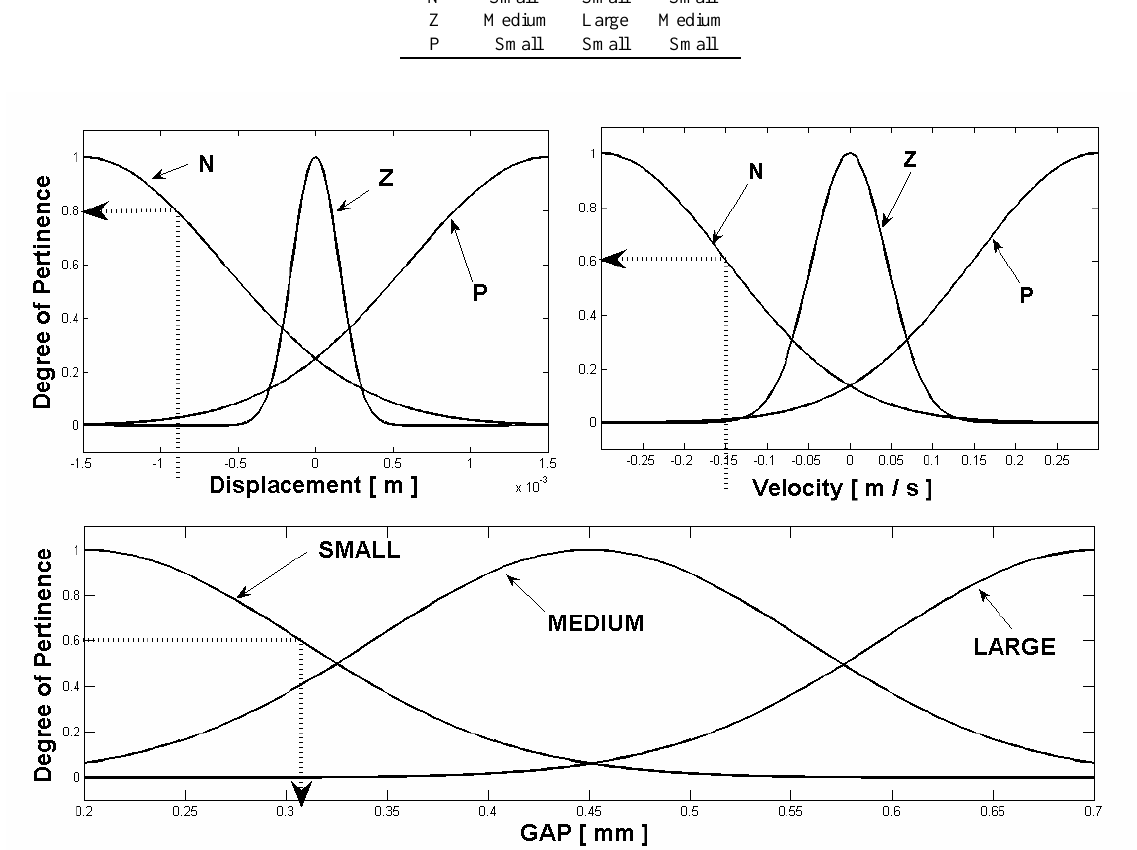
Fig. 12. Inputs and output pertinence functions of fuzzy